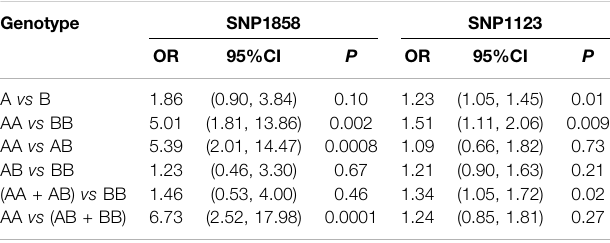
TABLE 4 | The relationship between SNP1858 and SNP1123 polymorphism of PTPN22 gene and ITP susceptibility.